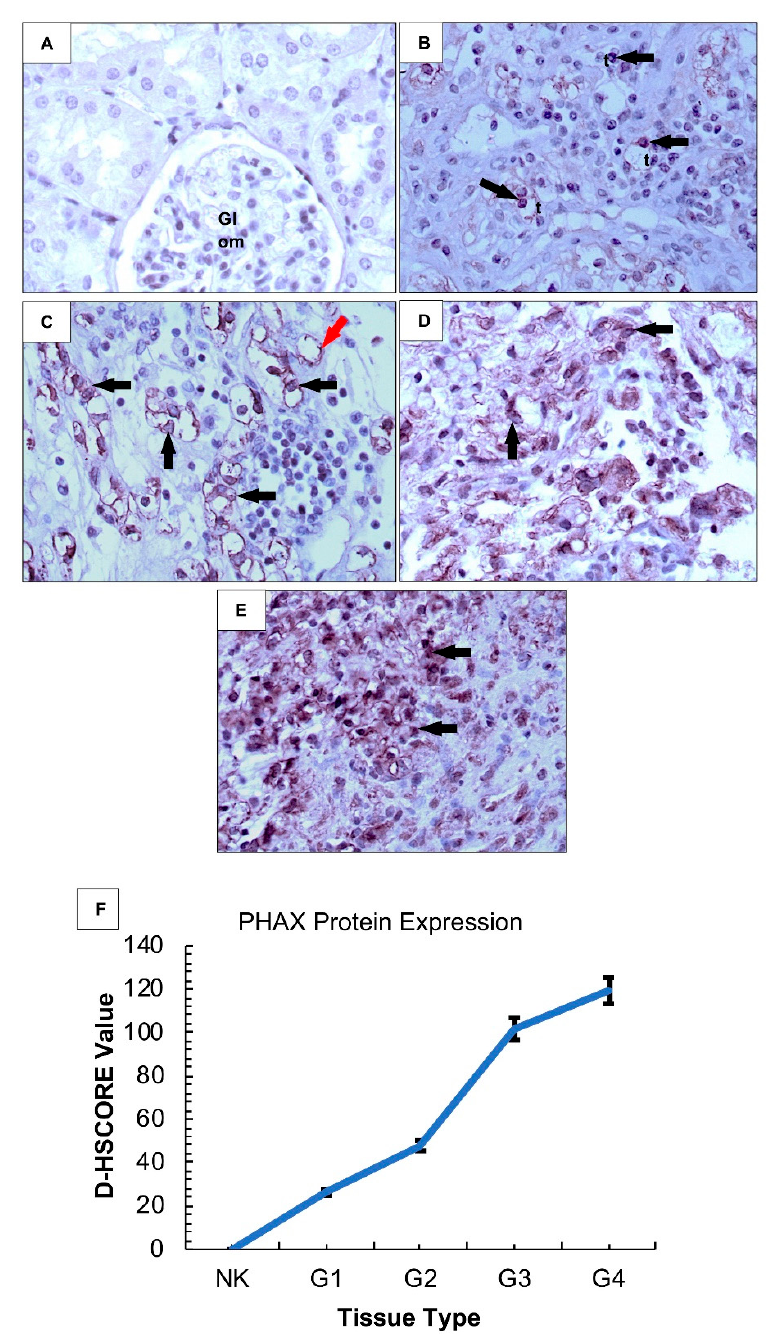
Figure 2. PHAX protein expression in clear cell renal cell carcinoma (ccRCC) grades 1–4 and adjacent normal kidney (NK) cells. ( A ) NK cells show a negligible level of PHAX expression, with a mild signal detected in some tubular epithelial cells ( t ) in ccRCC grade 1 ( B ), increasing in intensity and frequency in high grade tumours (G2–G4) within the intertitial capillary network ( red arrow ) and in sheets of tumour cells ( arrows ), both cytoplasmic and nuclear patternx ( C – E ). Signal intensity is presented as a digital histological score (D-HSCORE) with high grade tumours showing statistically significantly increased expression for PHAX (F). (NK vs. G1—(* p < 0.05), NK vs. G2—(** p < 0.01), NK vs. G3 or G4—(*** p < 0.0001), G1 vs. G2—(* p < 0.05), G1 vs. G3 / G4—(** p < 0.01), G2 vs. G3—(** p < 0.01), G3 vs. G4—(ns)). Bars = means + SEMs. N = 3 per group with similar results. Original magnification ×250.